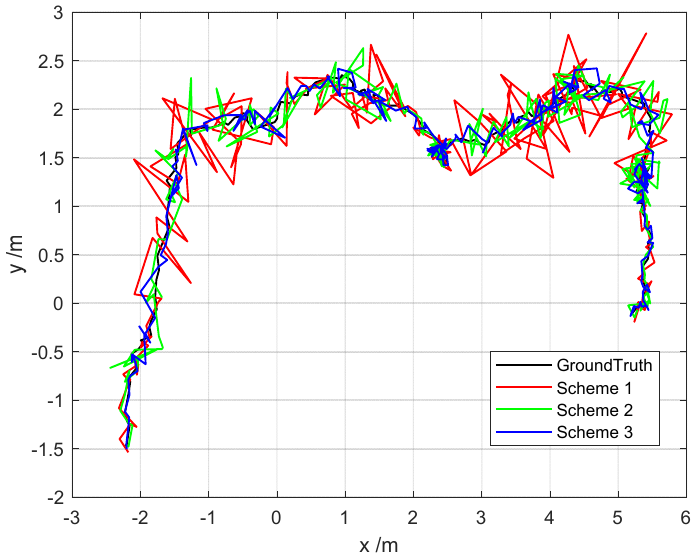
Figure 13. Position estimation for different scenarios.